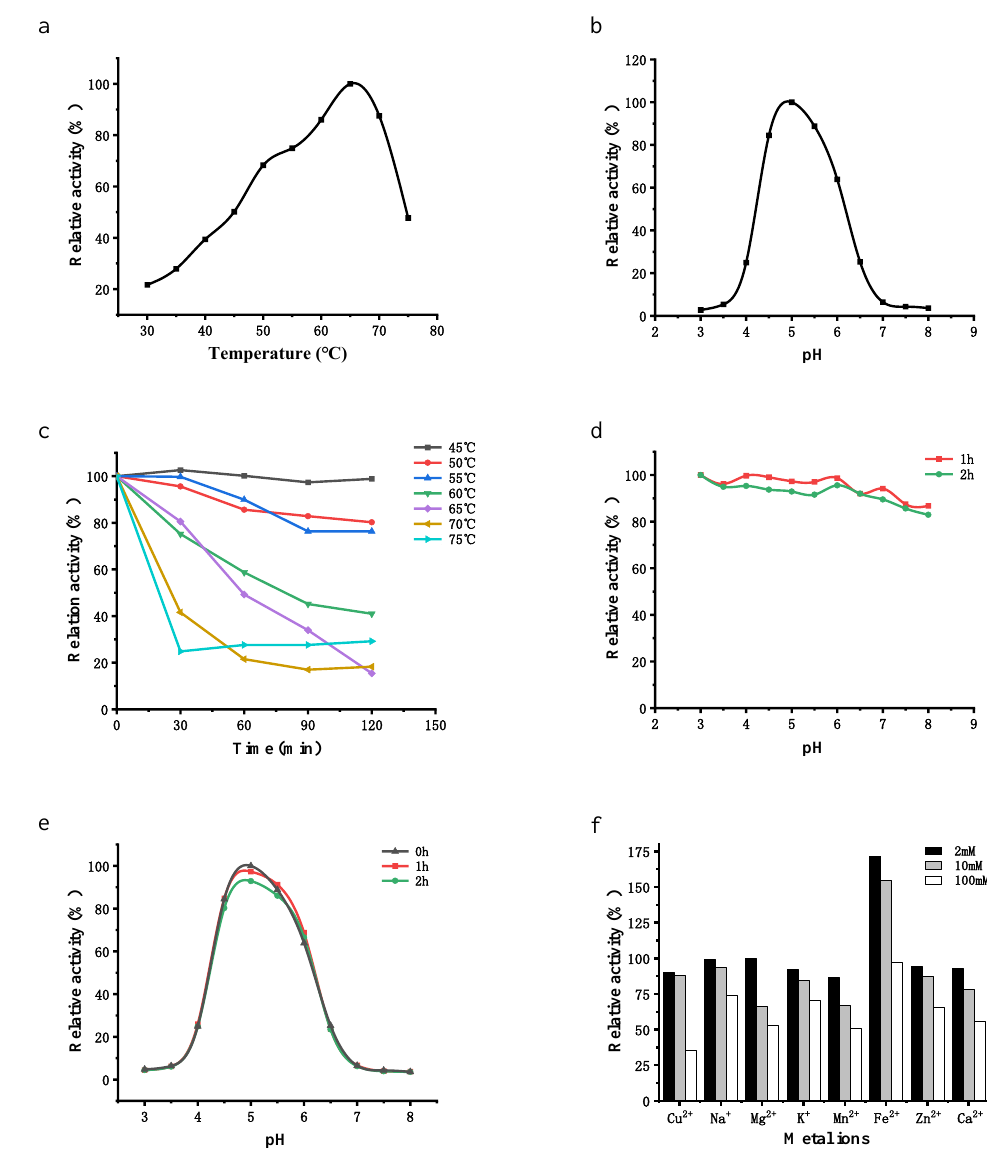
Figure 3. Biochemical characterization of α -galactosidase. ( a ) Effects of temperature on the activity of α -galactosidase. ( b ) Effects of pH on the activity of α -galactosidase. ( c ) Effects of temperature on the stability of α -galactosidase. ( d , e ) Effects of pH on the stability of α -galactosidase. ( f ) Effects of metal ions.